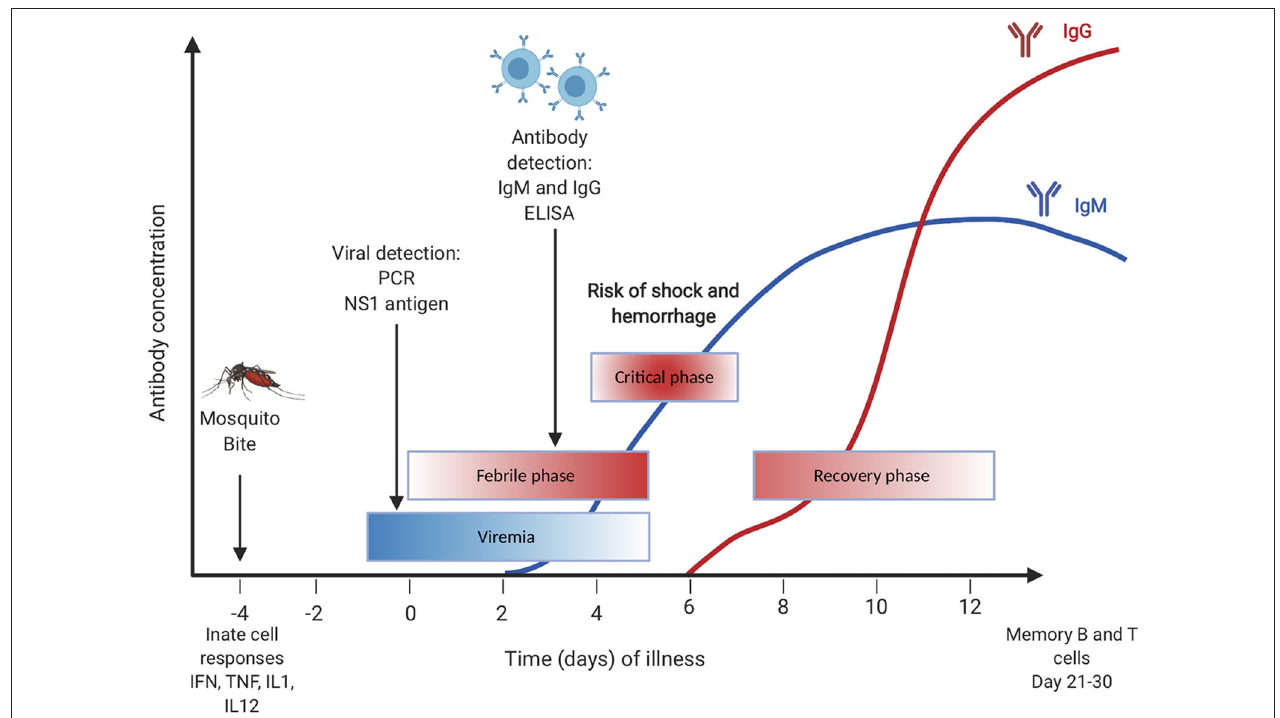
FIGURE 1 | Primary dengue infection with timing of diagnostic